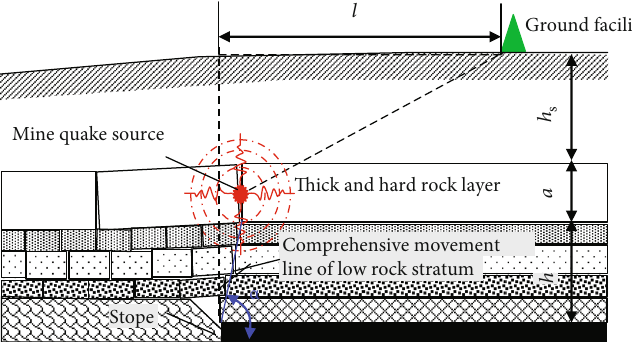
Figure 6: In fl uence space distance of the mine ground vibration damage boundary.